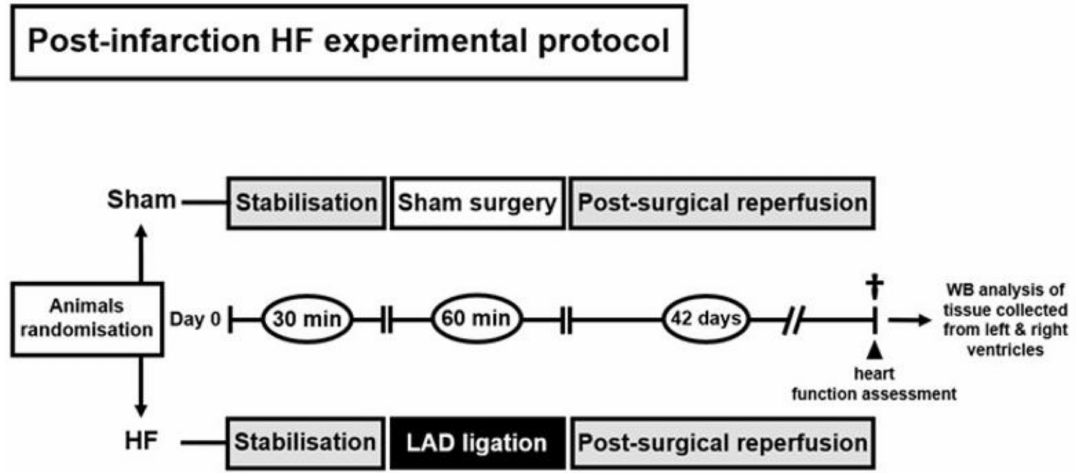
Figure 5. Illustration showing experimental protocol. Sham—group subjected to surgery without coronary occlusion; HF—group subjected to 60 min coronary occlusion with subsequent reperfusion and development of contractile dysfunction and remodeling over the course of 42